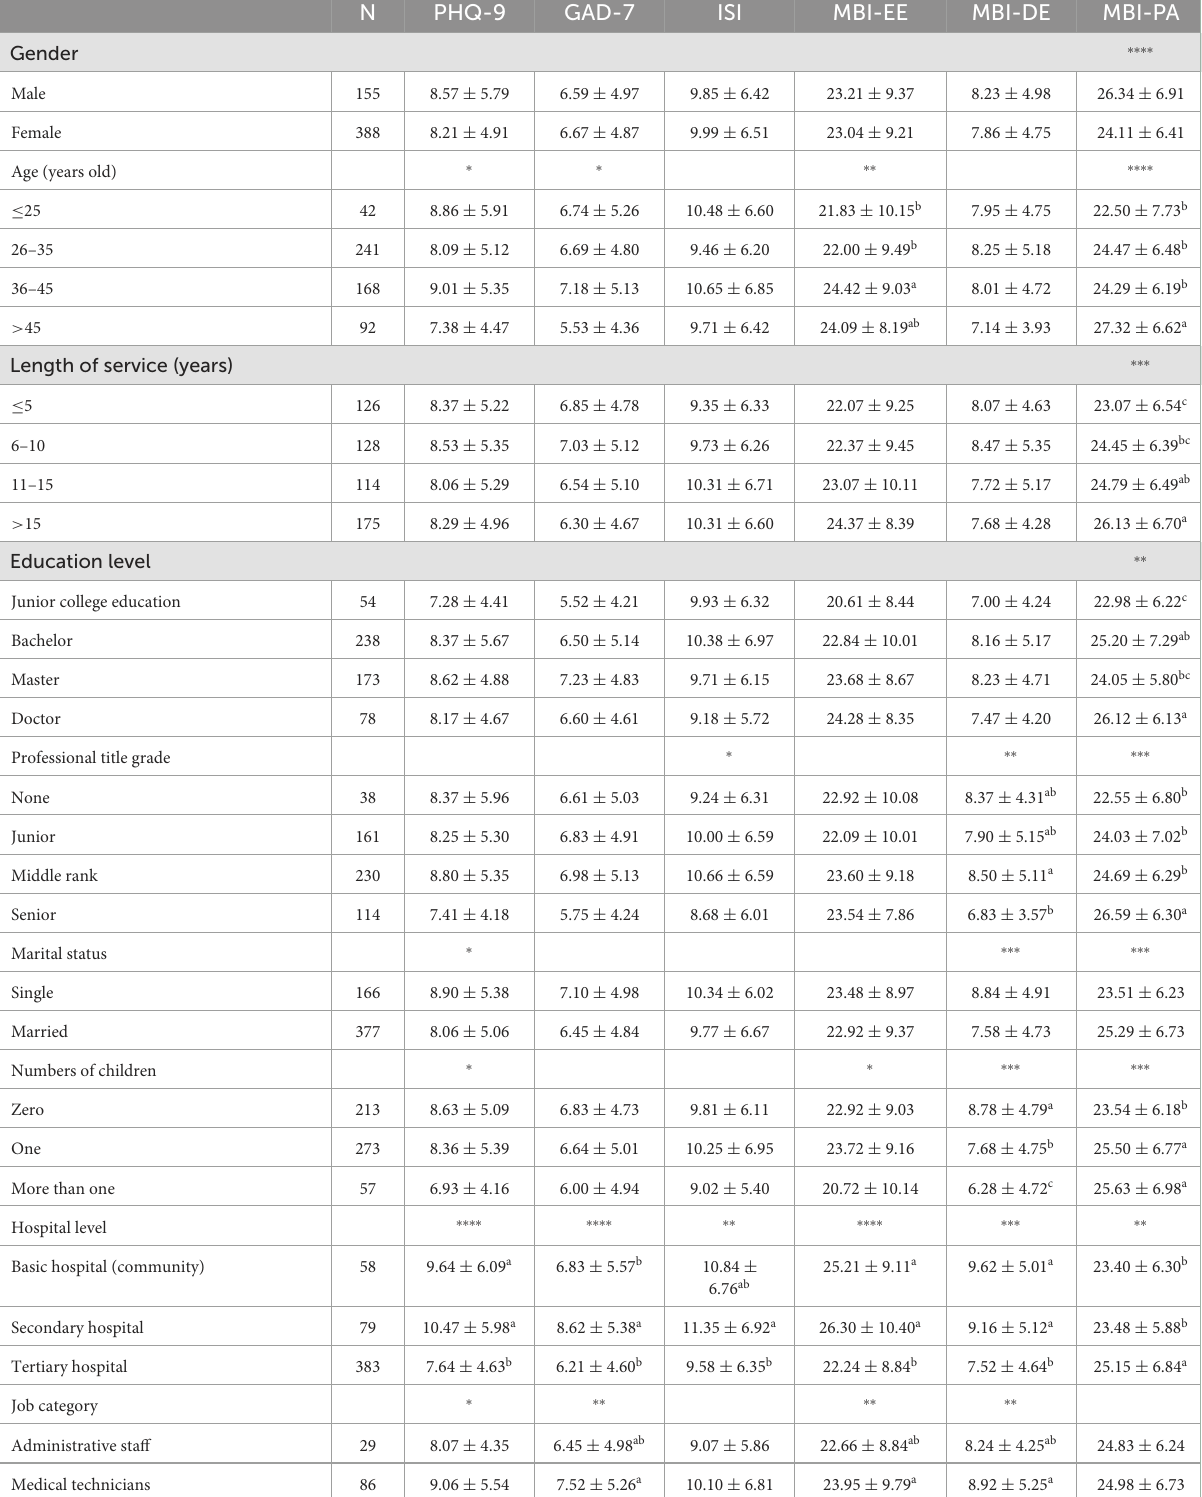
TABLE 4 Single factor analysis of job burnout, mental health and sleep status of medical workers in